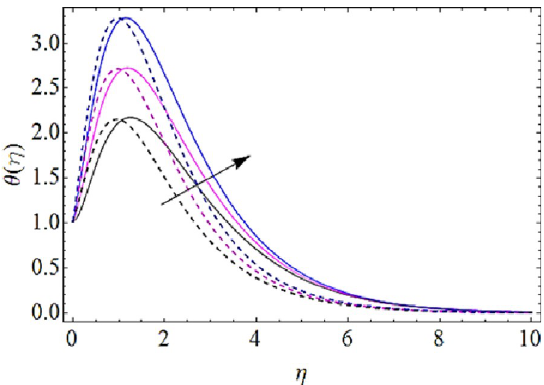
Fig 9. Thermal characteristics for different values of Brownian motion parameter.